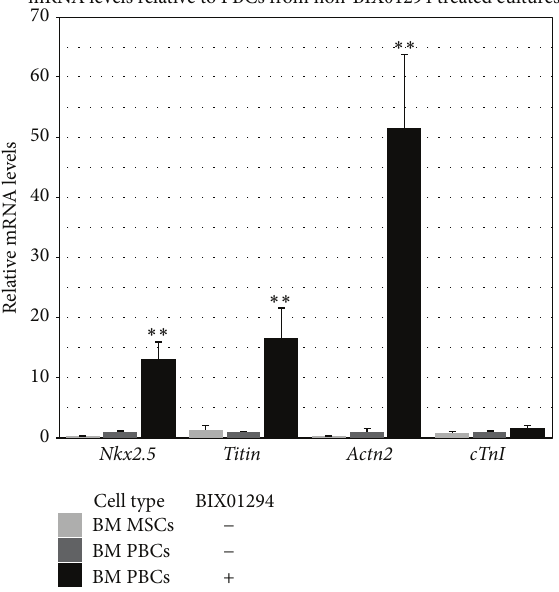
Figure 6: Cardiac differentiation of bone marrow-derived PBCs. PBCs collected from MSC cultures pretreated with or without BIX01294 were aggregated by hanging drop for 4 days and then differentiated in 50% CCM following their transfer to tissue culture plastic. Thereafter, RNA was isolated from these cultures and analyzed for cardiac gene expression using real-time qPCR. As a comparative control, nontreated MSCs were also assayed by qPCR. As shown, BIX01294 exposure produced PBCs that exhibited significant upregulation of the early cardiac markers Nkx2.5 , titin , and Actn2 , as compared to PBCs obtained from BIX01294-negative cultures. In contrast, expression of the late cardiac marker cTnI was not stimulated, which indicates the conditions used in these assays were not sufficient to support complete myocyte differentiation. ∗∗ 𝑝 < 0.005